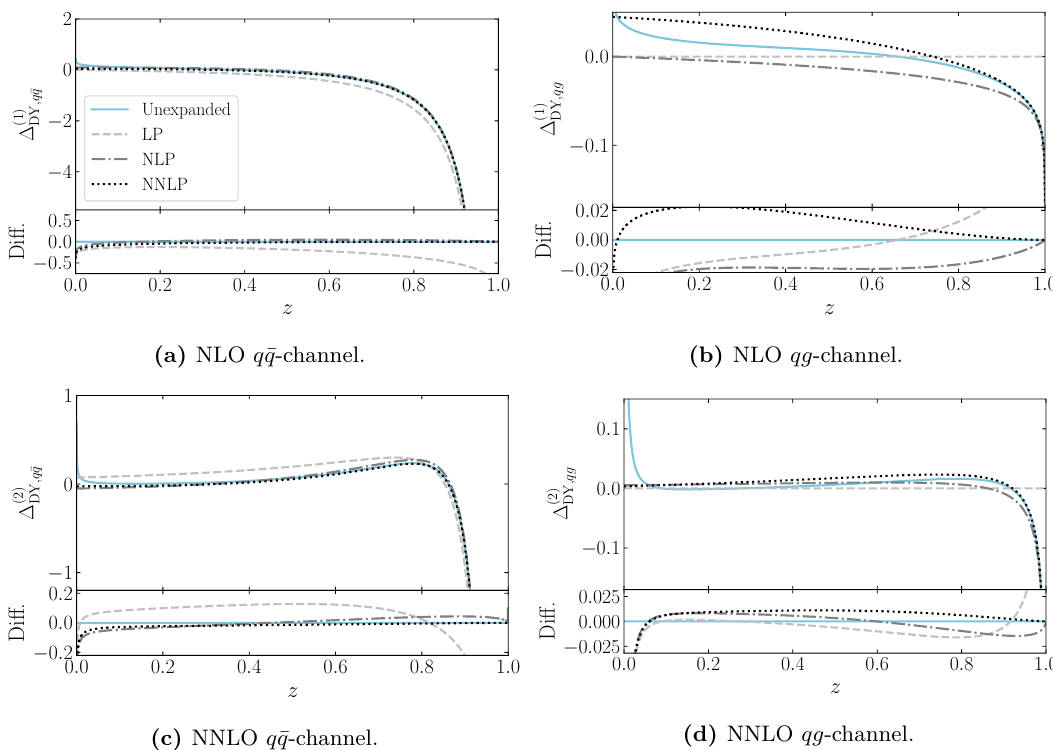
Figure 2. Expansions of the NLO (a,b) and NNLO (c,d) partonic coefficients for the DY production of an off-shell photon. The labeling is the same as in figure